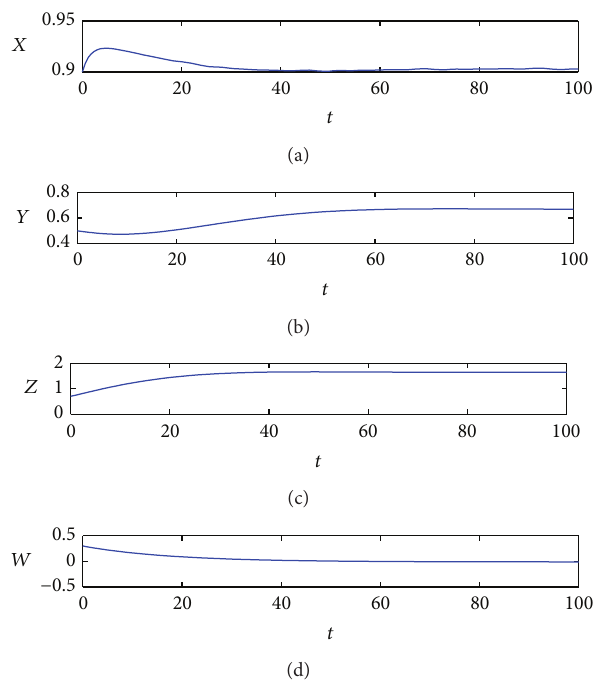
Figure 8: The time series of 𝑋(𝑡),𝑌(𝑡),𝑍(𝑡),𝑊(𝑡) when 𝑑 2 = 1.4 .